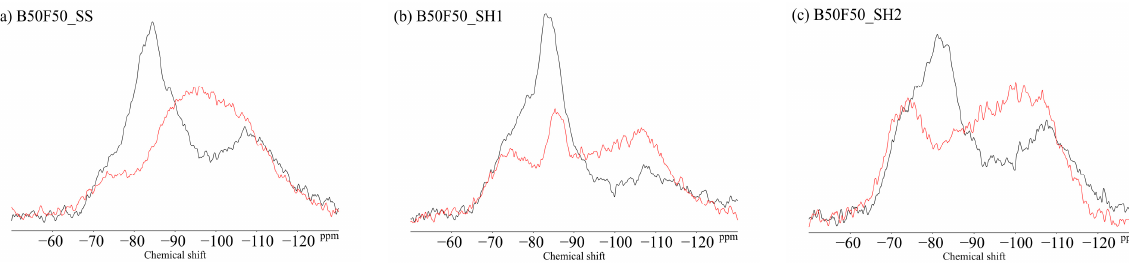
Figure 12. Solid-state 29 Si MAS NMR chemical shifts for ( a ) B100_SS, ( b ) B100_SH1, and ( c ) B100_SH2 samples.